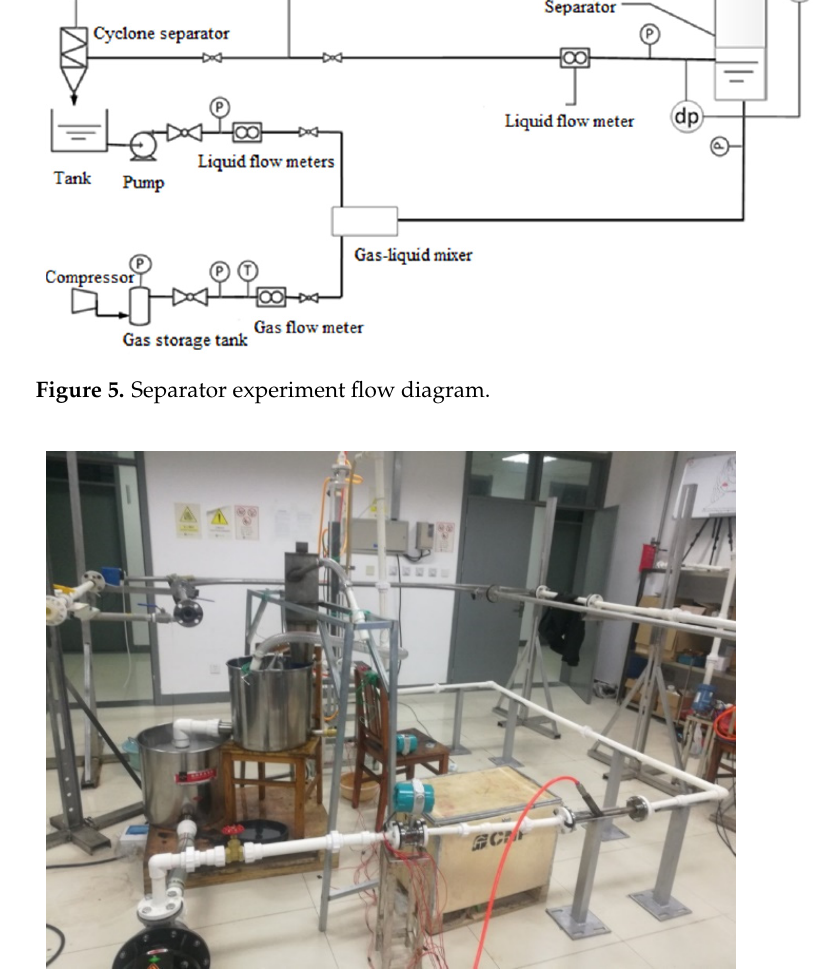
Figure 6. Experimental Loop Diagram.